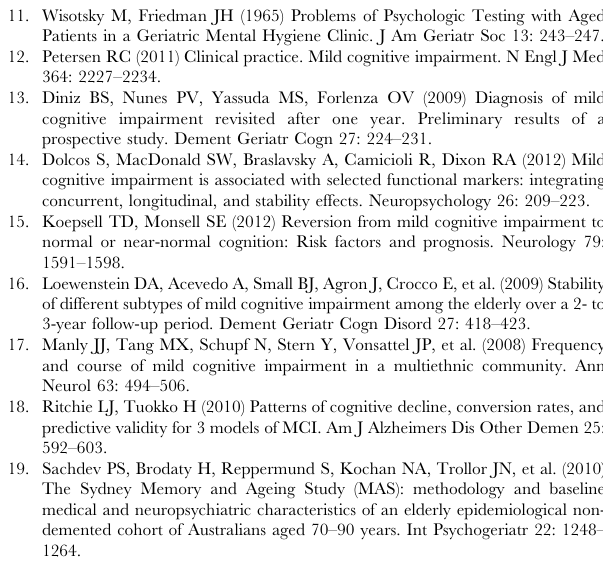
Table S1 Cognitive domains, tests, normative data sources and demographic adjustments used in diagnos- ing MCI in the Sydney MAS. Table S2 Baseline region of interest volumes (mm 3 ) for reverters and non-reverters in the MRI subsample. Table S3 Baseline characteristics of participants either with or without a diagnostic classification at